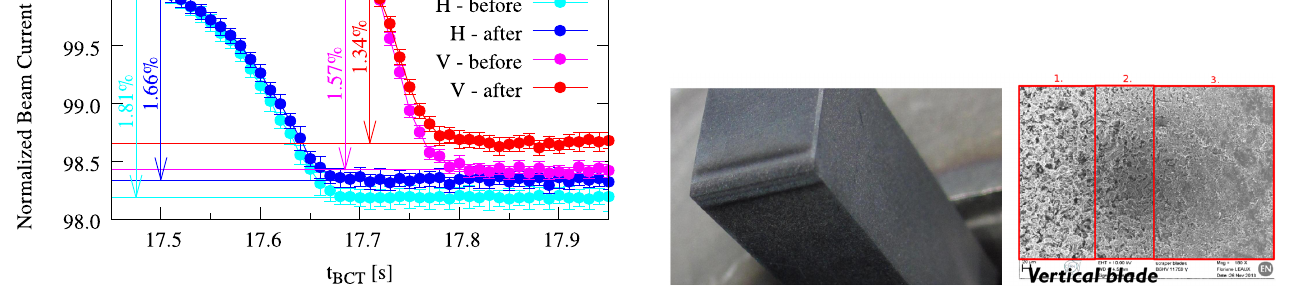
FIG. 10. Vertical blade of the tested scraper as when dis- mounted (left frame) and as visualized with the SEM [19] (right frame). The SEM image is zoomed on the region around the chamfer in view of the beam and hence affected by the burst. Three zones with different levels of porosity were identified. The horizontal blade shows a very similar degradation of the